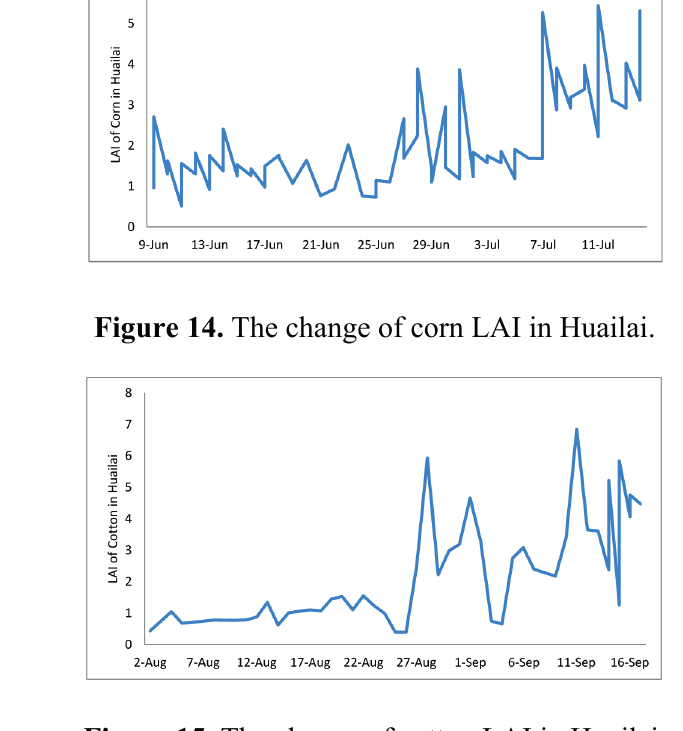
Figure 15. The change of cotton LAI in